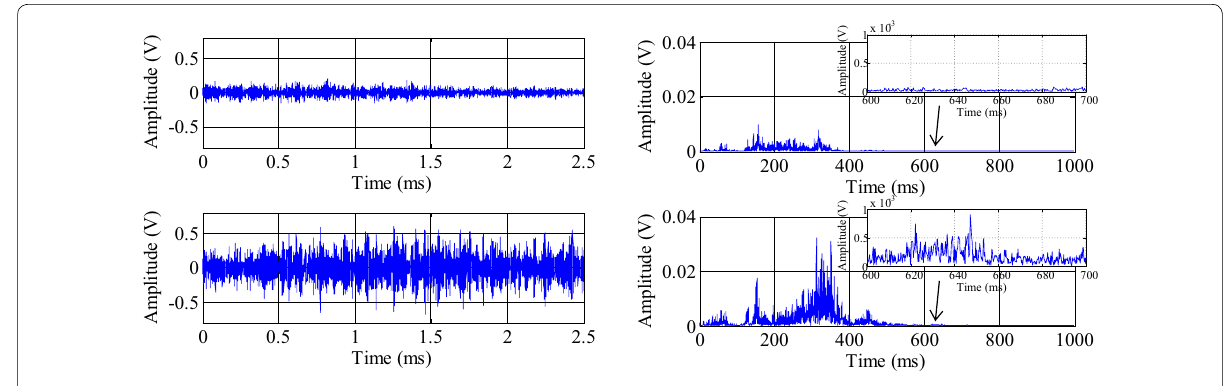
a Waveforms of no-burn and burn signal by laser Figure 4 AE signals produced by laser heating